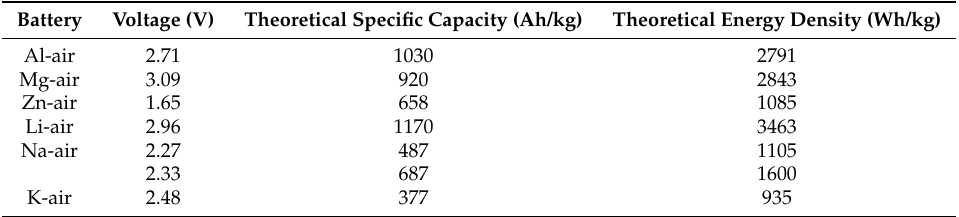
Table 7. Parameters of the metal-air batteries